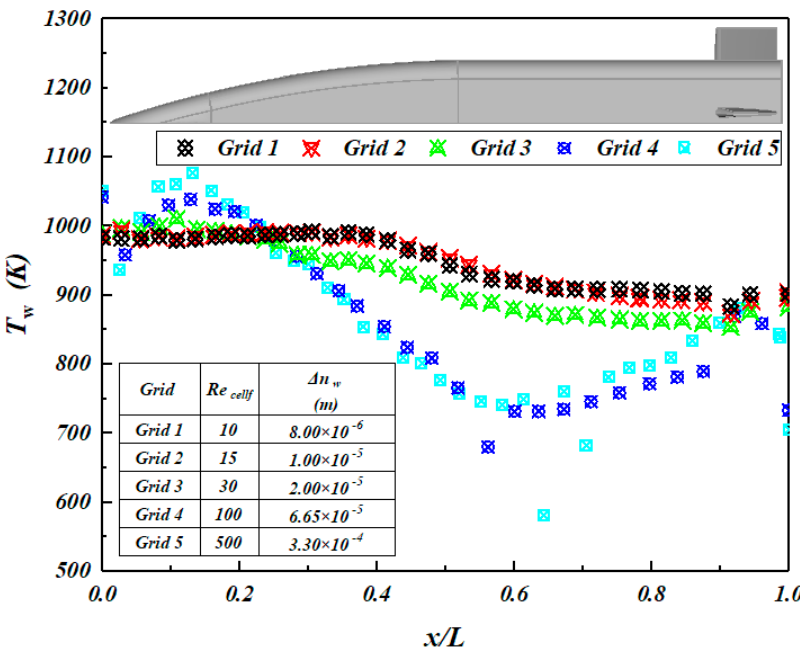
Figure 3. Grid independence verification of numerical calculation in this study.